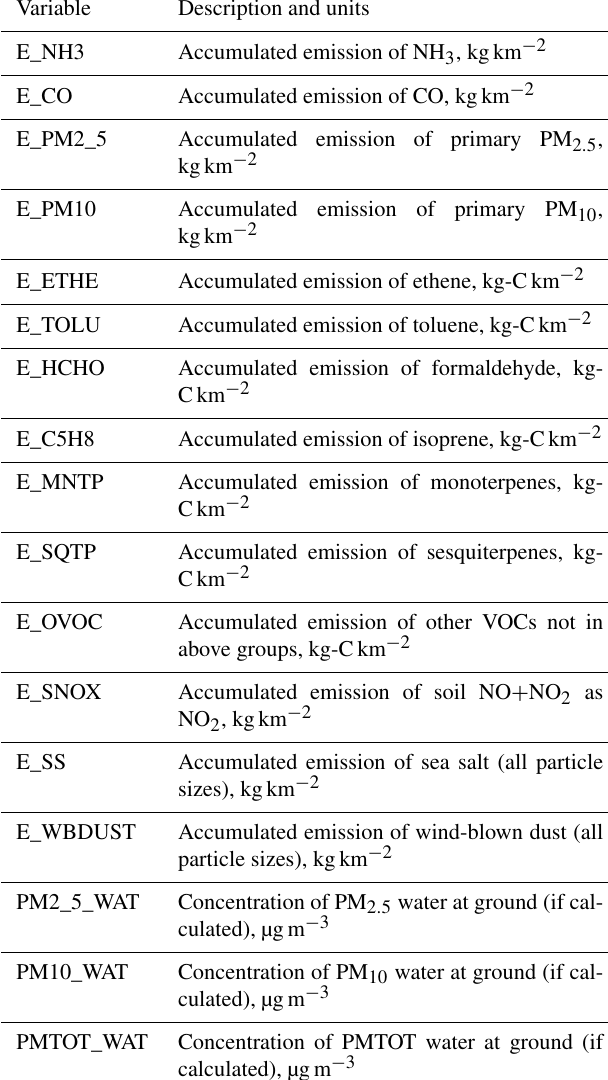
Table A2. Continued.